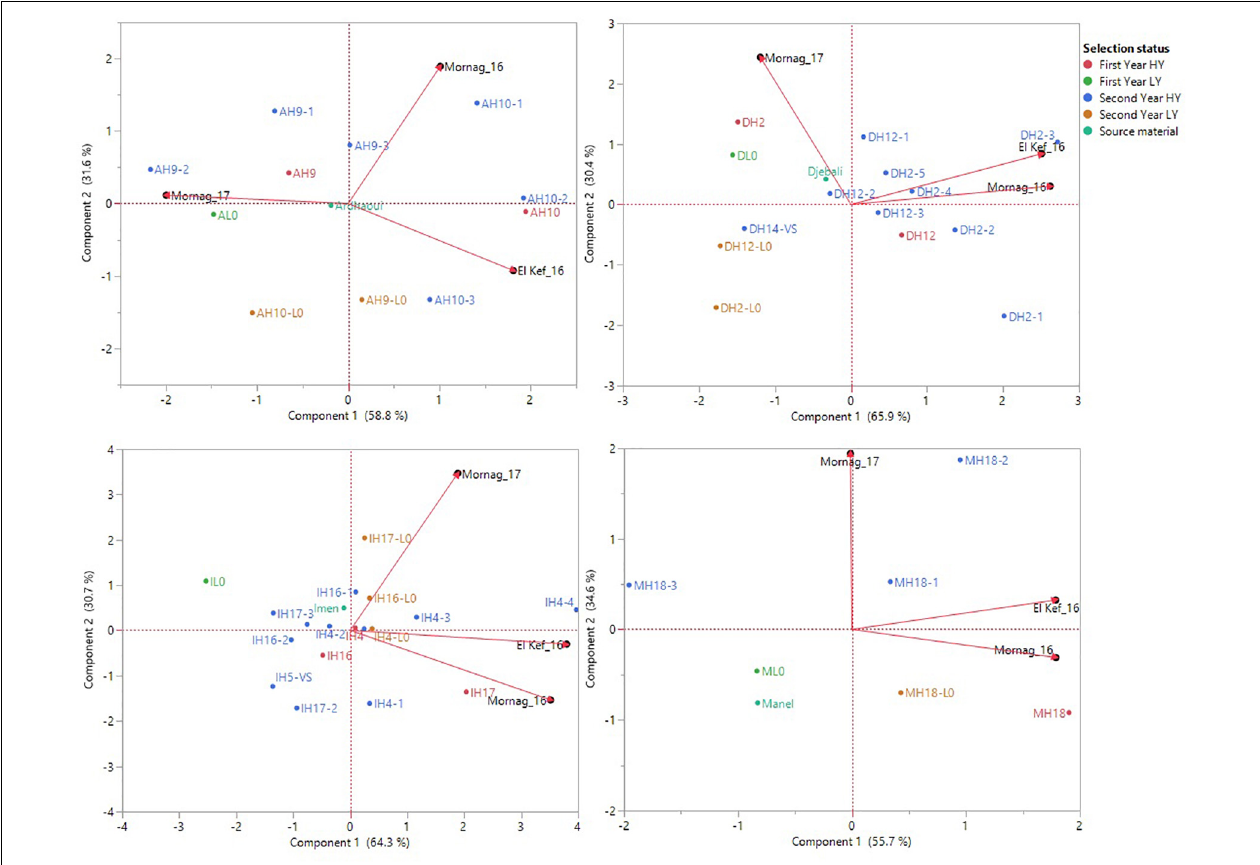
FIGURE 3 | Source material-based GGE biplot analysis for grain yield performance of the barley lines evaluated under dense stand trials in three environments in Tunisia. Upper left: landraces Ardhaoui and derived lines, upper right: landrace Djebali and derived lines, bottom left: variety Imen and derived lines, bottom right: variety Manel and derived lines. Due to the limited number of lines derived from variety Rihane, GGE biplot analysis was not performed.